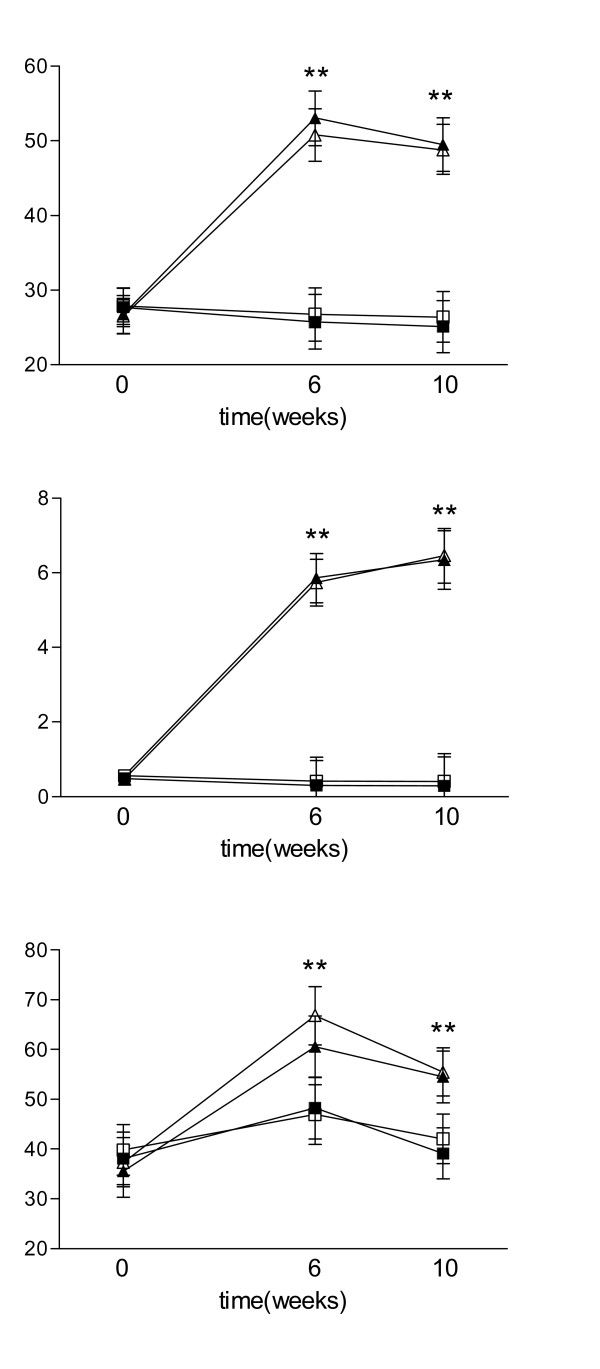
Plasma concentrations of vitamin C & E and β-carotene. Plasma concentrations of vitamin C & E and β-carotene were measured at base line, 6 and 10 weeks. Data are expressed as LSM (± 95% CI). Levels in the micronutrient groups (micronutrient group ▲ and micronutrient + colostrum group △) are significantly different from levels in non-vitamin group (control ■ and colostrum group □) with ** p < 0.0001.